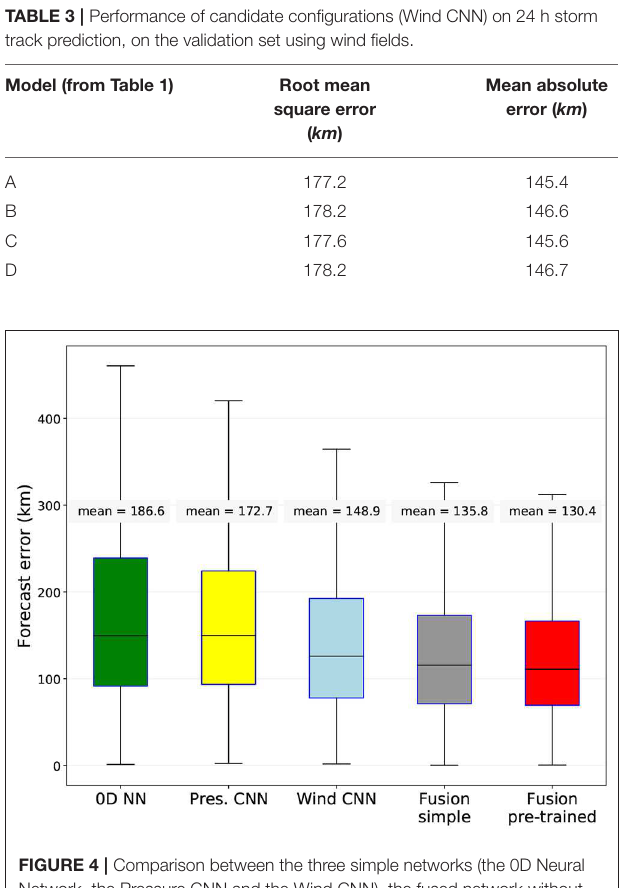
FIGURE 4 | Comparison between the three simple networks (the 0D Neural Network, the Pressure CNN and the Wind CNN), the fused network without separate pre-training (gray), and the fused network with pre-training (red, proposed method). 24 h-forecast results on the test set (storms coming from all oceanic basins), in distance between predicted and real